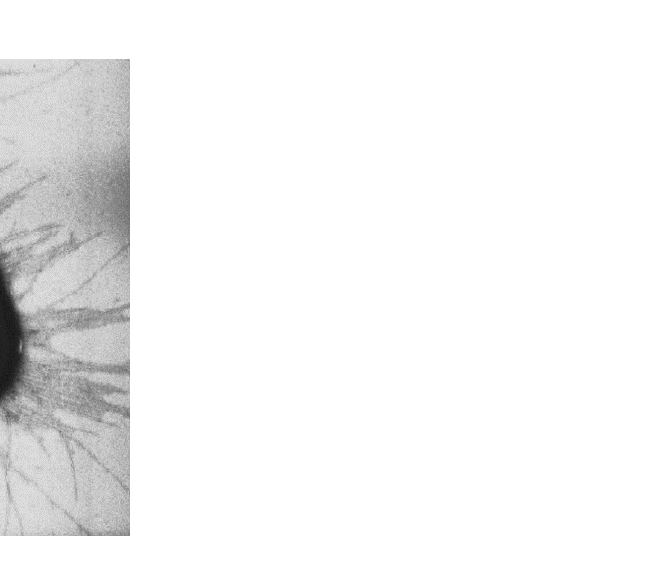
Figure 8. Fimbriae covering E. coli . Reuse permitted by the Creative Common CC BY license from Gross, L. Bacterial Fimbriae Designed to Stay with the Flow. PLoS Biology 2006 , 4 , e314, doi:10.1371/journal.pbio.0040314. Image from Manu Forero, doi:10.1371/journal.pbio.0040314.g001.